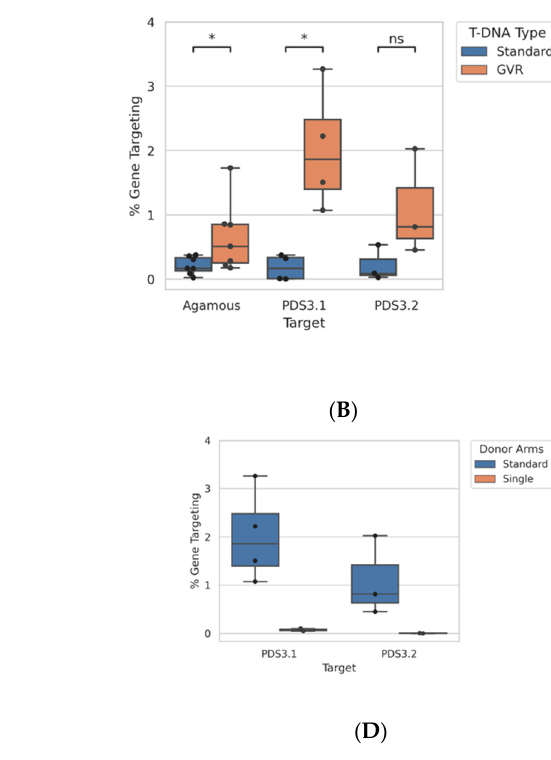
Figure 2. Efficiency of genome editing as assessed by ONAS and PANGEA . ( A ) Corrected percent targeted mutagenesis at three loci when delivered a nuclease with and without a GVR. ( B ) Percent gene targeting at three loci when delivered nuclease and donor with 500 bp homology arms encoding a 18bp insertion with and without a GVR. ( C ) Percent gene targeting using donors of various divergence; 2.0% and 3.3% diverged donors use engineered SNPs at a consistent interval (50 bp and 33 bp, respectively) while the 10.0% diverged donors use the natural variance between the two PDS loci. All samples were delivered with a nuclease and GVR. Values at PDS3.1 correspond to 0.0, 1.0, and 10.0, respectively. ( D ) Percent gene targeting at PDS3.1 and PDS3.2 when using two 500 bp donor arms or a single 500 bp donor arm. All samples delivered with a nuclease and GVR. * Indicates a p -value < 0.05 from a Mann–Whitney test. ns—no statistical